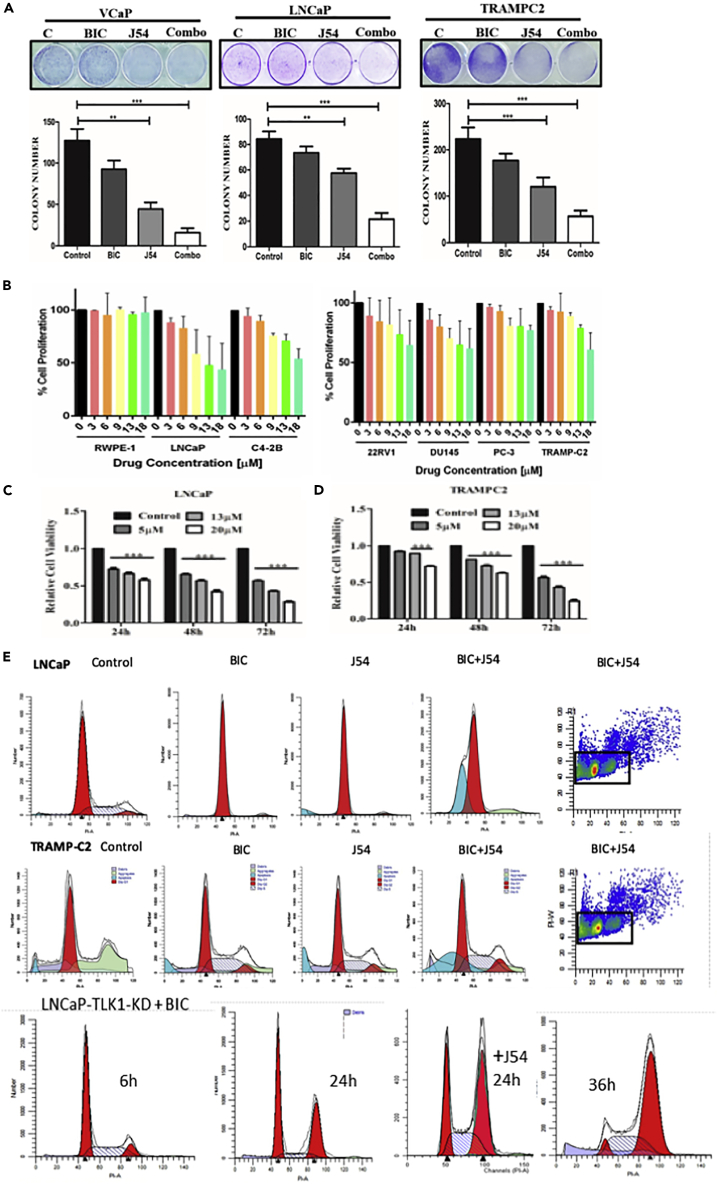
J54 in Combination with an Anti-androgen (Bicalutamide) Induces Apoptosis in AS PCa CellsAll experiments were conducted in triplicates.(A) Clonogenic assays of AS PCa cells (VCaP, LNCaP, and TRAMP-C2) after treatment with BIC, J54, or combination. The cells were grown for 2–3 weeks and stained with crystal violet. All experiments were conducted in triplicates. Two-way ANOVA tests were done to compare the group for statistical significance; ∗∗ p < 0.01, ∗∗∗ p < 0.001.(B) Cell proliferation assays of the indicated cell lines incubated with different concentrations of J54. The cell lines used were human “normal” RWPE-1, LNCaP, (LNCaP-derivative) C4-2B, 22RV1, DU14, and PC3 and mouse TRAMP-C2. All experiments were conducted in triplicates, and two-way ANOVA tests were done to compare the group for statistical significance.(C and D) Cell proliferation of LNCaP (C) and TRAMP-C2 (D) were determined during 3-day incubation with different concentration of J54 (MTS assay). Two-way ANOVA tests were done to compare the group for statistical significance; ∗∗p < 0.01, ∗∗∗p < 0.001. All experiments were conducted in triplicates.(E) Cell cycle analysis by PI-FACS of LNCaP and TRAMP-C2 cells incubated for 24 h with BIC, J54, or combination (5 μM each). Representative analysis of two independent experiments are shown. LNCaP cells overexpressing dominant-negative TLK1-KD treated with BIC accumulate in G2 before dying over the next few days.